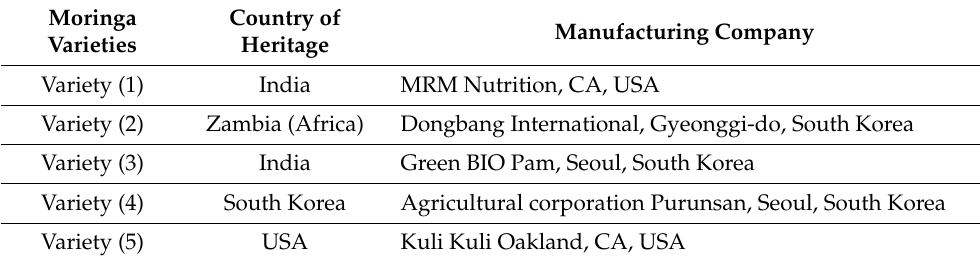
Table 1. List of moringa powder samples belonging to different geographical